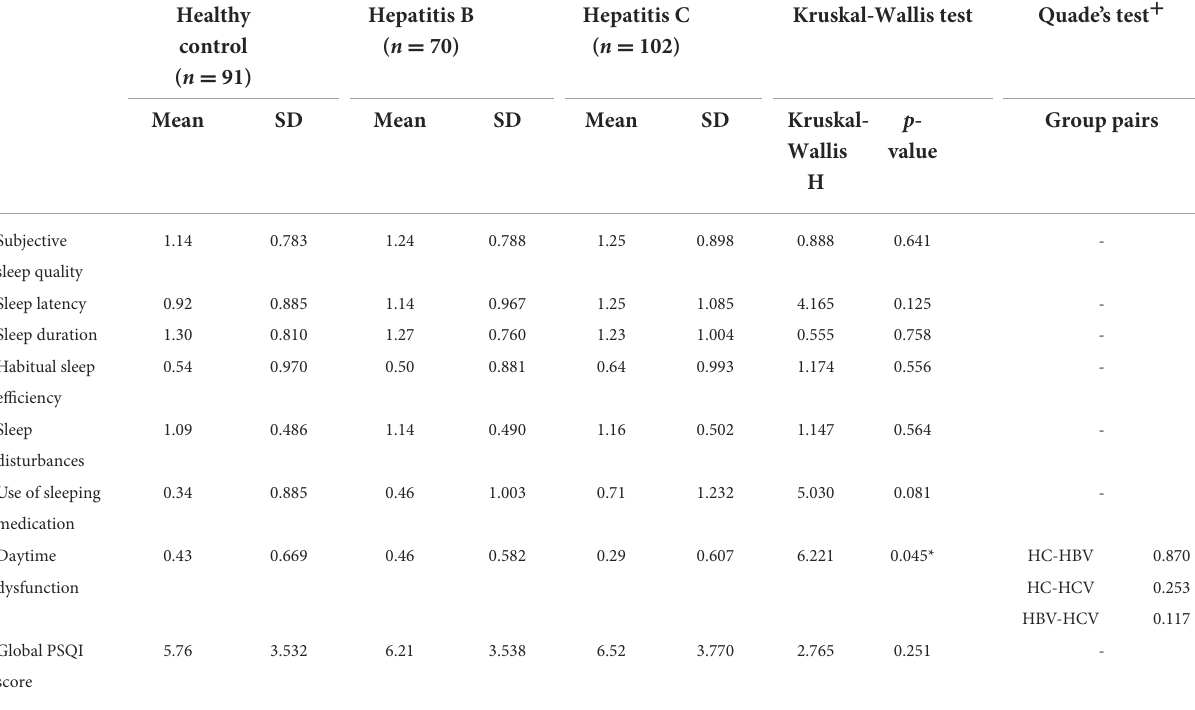
Hepatitis B ( n = 70)